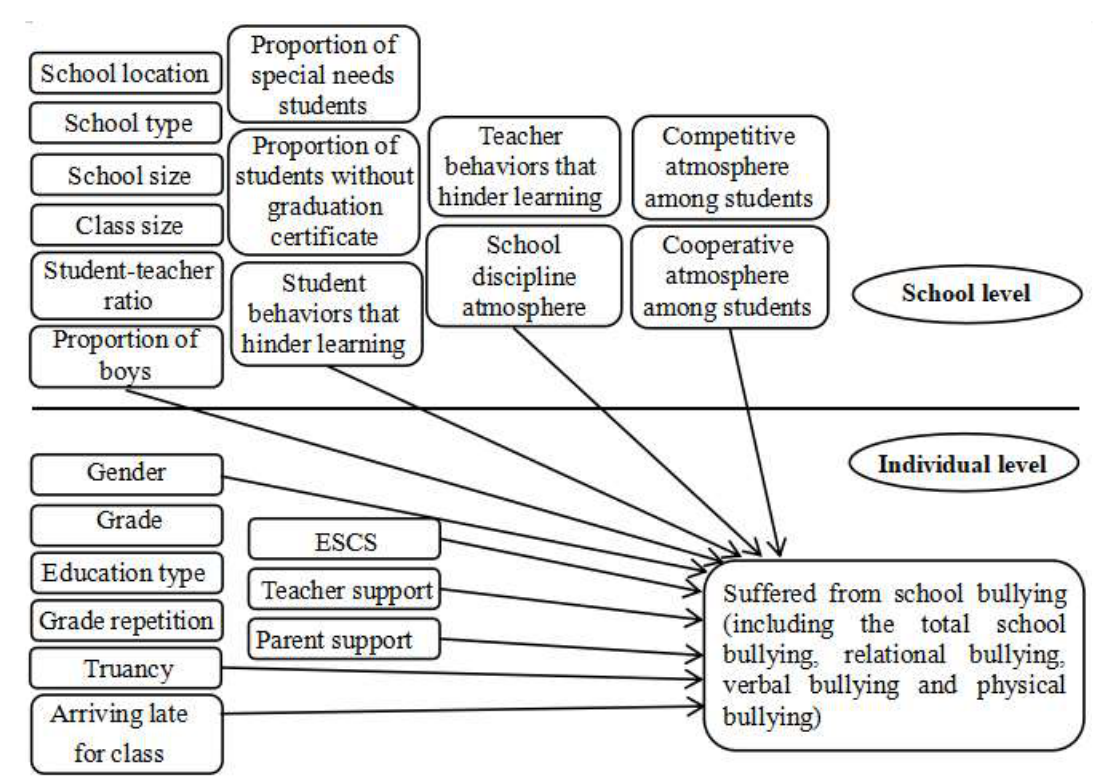
Figure 1. The structure of the study.